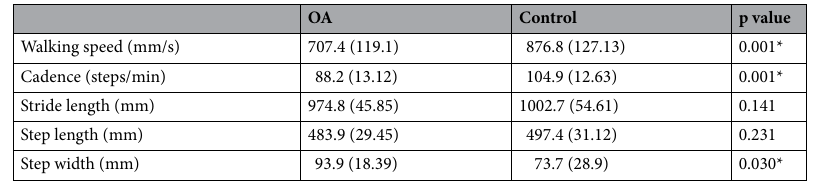
Table 2. Means (standard deviations) of the spatiotemporal parameters during walking in the knee osteoarthritis group (OA, n = 15) and healthy controls (Control, n = 15). *OA significantly different from Control.